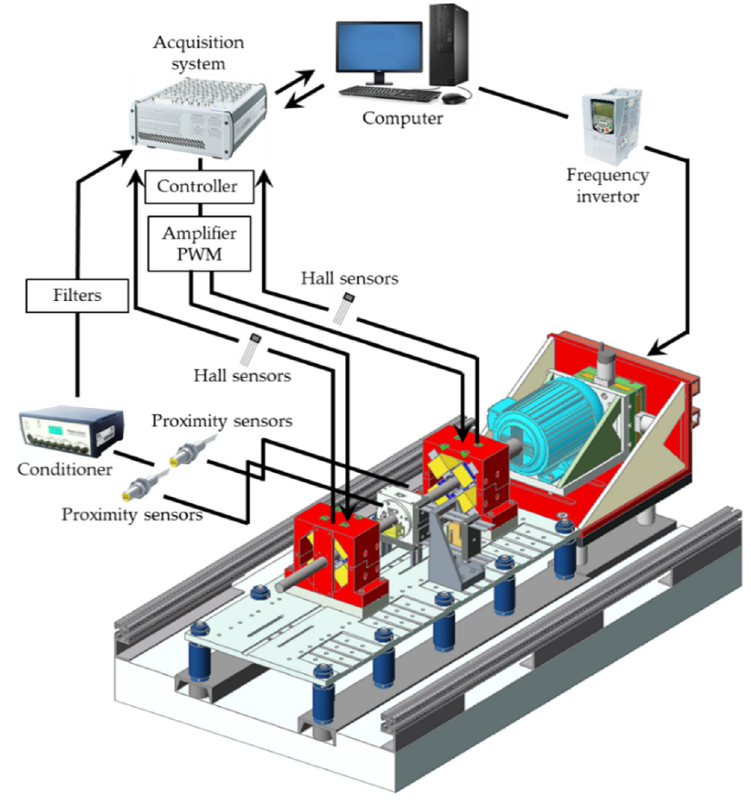
Figure 16. Flowchart of the test bench.